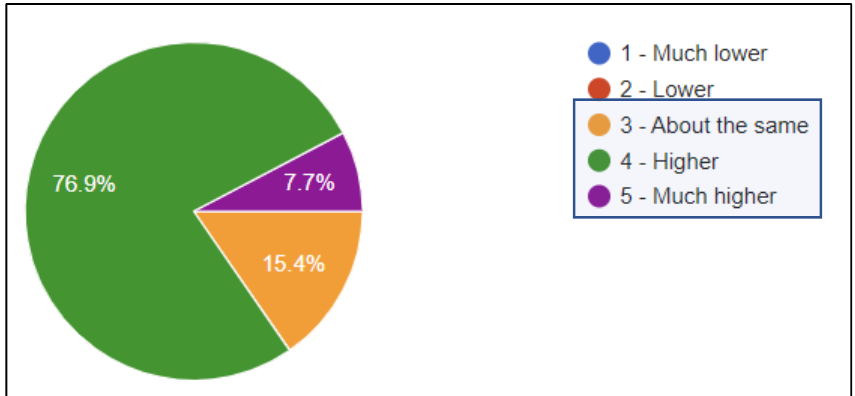
Figure 10. Students’ analysing skills before experiential learning in smart classroom (Subject 1).